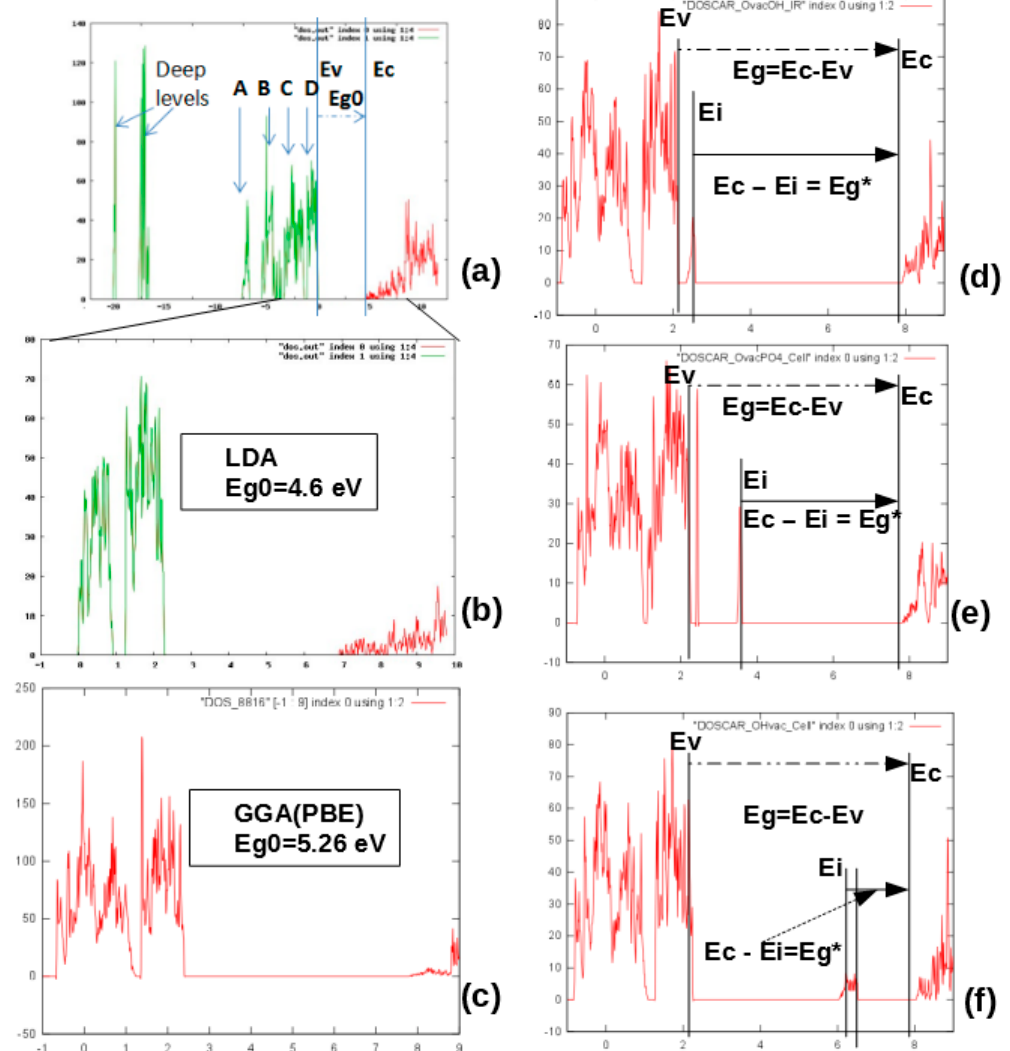
Figure 11. Density of electronic states (DOS) for HAp unit cell: ( a ) initial pure HAp with 44 atoms in hexagonal P6 3 unit cell lattice, including deep levels and A–D peaks in valence band computed in LDA by AIMPRO; ( b ) the same with main energies around Eg; ( c ) the same computed in GGA (PBE) by VASP; ( d ) DOS in case of O vacancy in OH group; ( e ) DOS in case of O vacancy in PO 4 group; ( f ) DOS in case of full OH vacancy. (Data presented here obtained after calculations using AIMPRO (LDA) [32] and VASP (GGA) [38], similar to our works [22,28]).